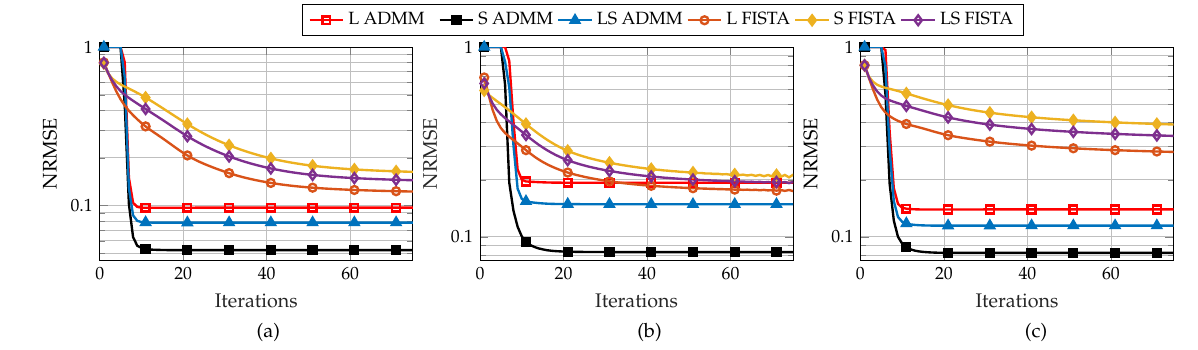
Figure 11. Average NRMSE of low-rank and sparsity contributions for K / MN = 100% for ADMM- and FISTA-based approaches. ( a ) rank ( L ) = 1 and p s = 0.1, ( b ) rank ( L ) = 2 and p s = 0.1 and ( c ) rank ( L ) = 2 and p s = 0.2. The ADMM-based approach achieves a lower NRMSE with a lower number of iterations compared to the FISTA-based